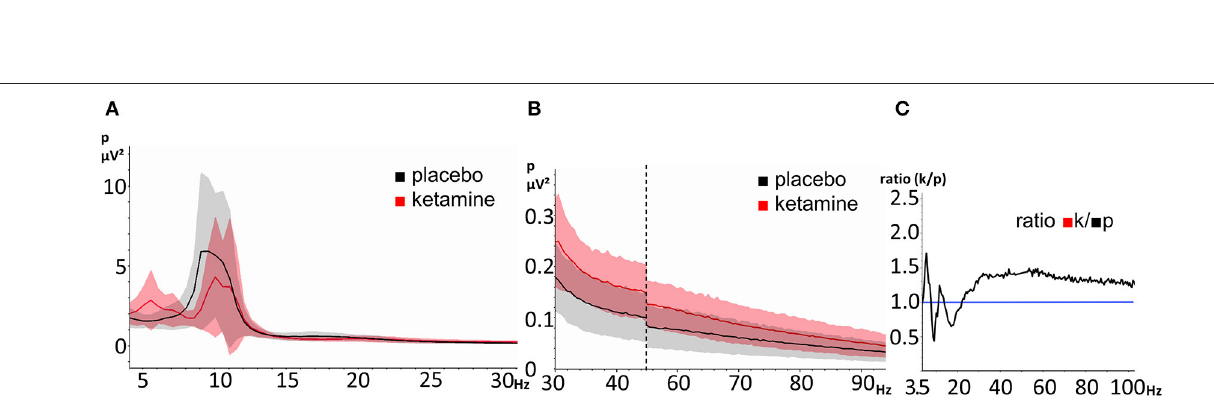
FIGURE 3 | EEG resting-state power spectra during the ketamine and placebo condition. The shaded areas represent the standard deviation (red = ketamine, gray = placebo). (A) frequency-range 3,5 Hz- 30Hz, (B) frequency-range 30–100Hz (the vertical dashed line indicates scale-break between 45 and 55Hz) and (C) ratio of power between ketamine (numerator) and placebo (denominator) (range: 3.5–100Hz). The horizontal line represents a ratio of 1.